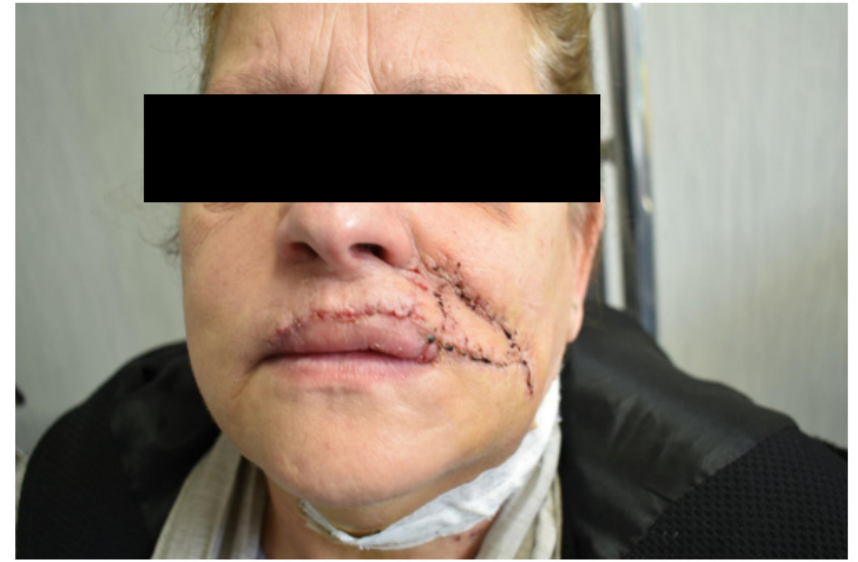
Figure 14. Case 6: Follow up at 15 days. Static position, frontal view.